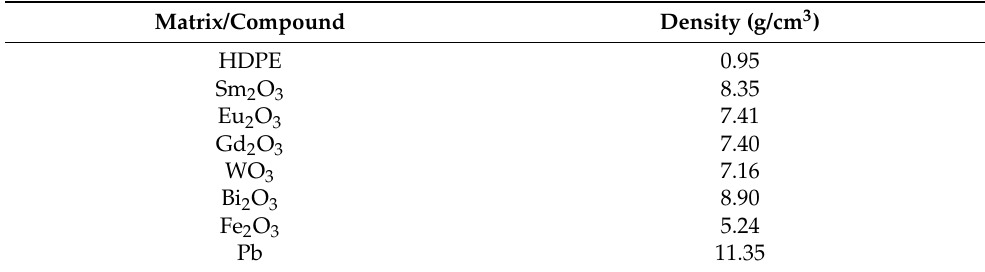
Table 1. Individual density of a pristine HDPE, rare-earth oxides, metal oxides, and Pb used for determination of densities for HDPE composites